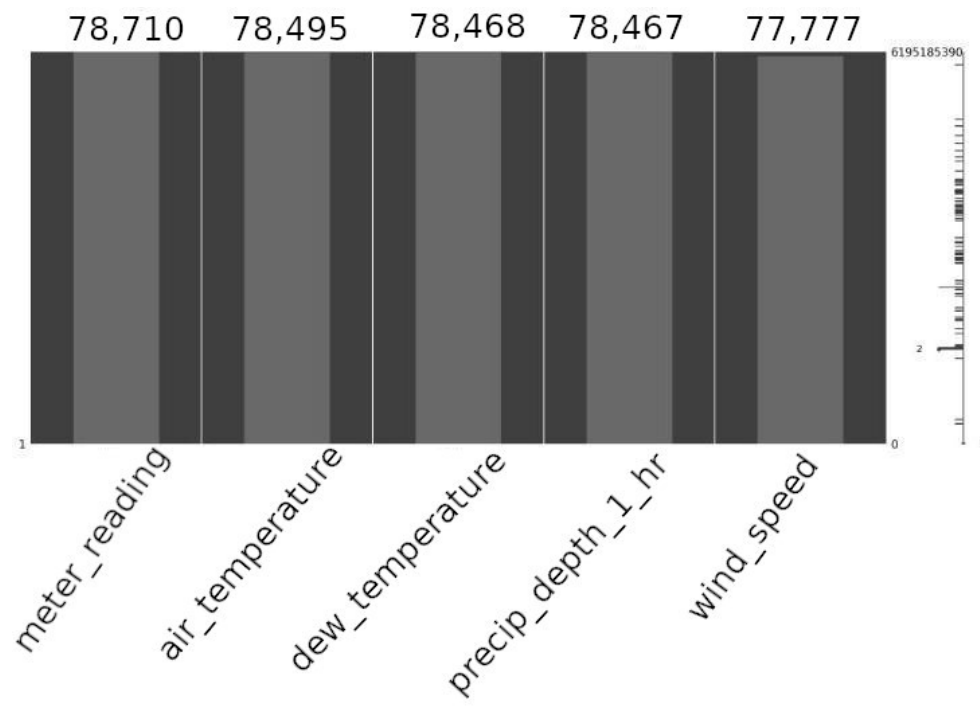
Figure 8. Removing missing